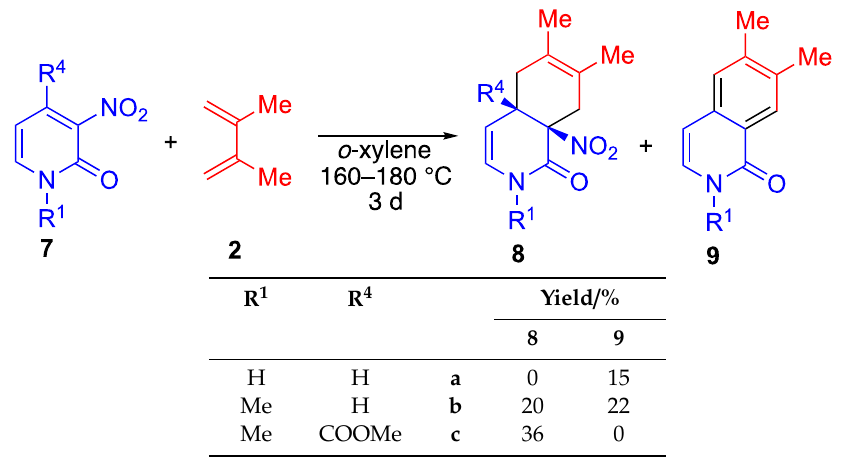
Table 3. Cycloaddition of 3-nitropyridones 7 with diene 2 .